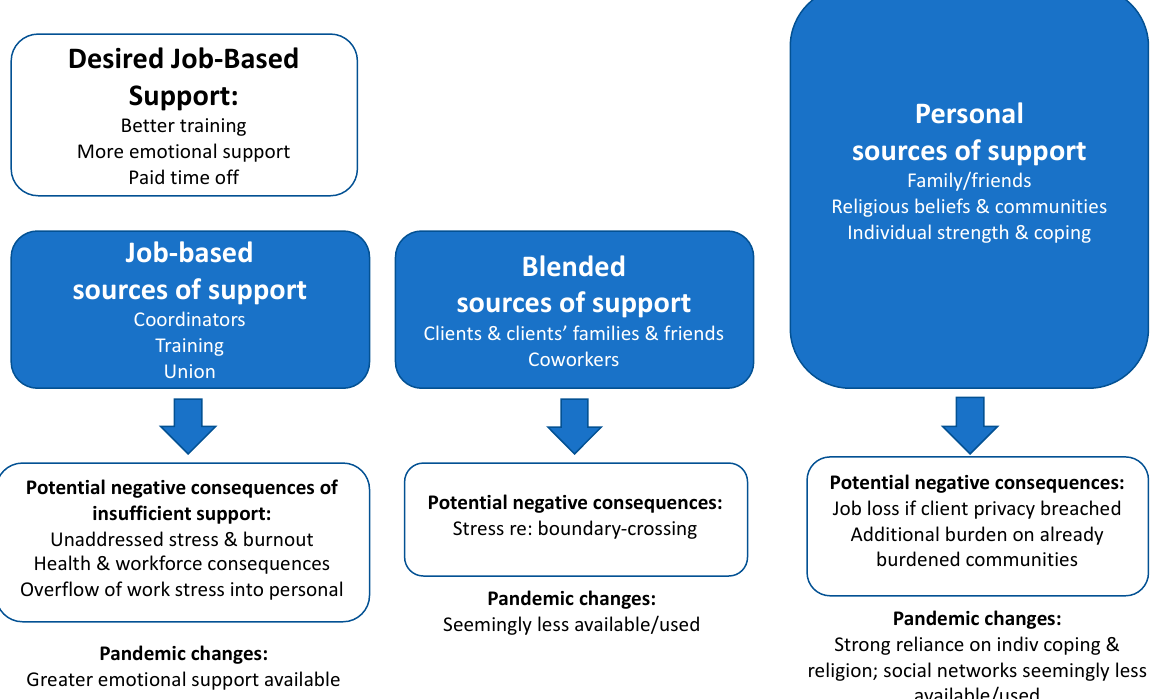
Figure 1. Sources of support used by home care aides to manage work stress from client death.